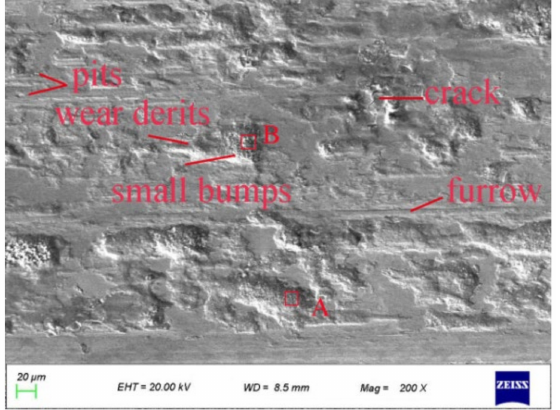
Figure 23. Wear morphology of the